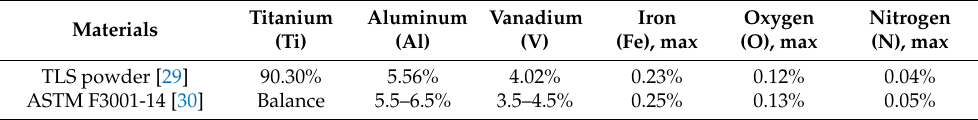
Table 1. Chemical composition of TLS Technik Ti6Al4V(ELI)